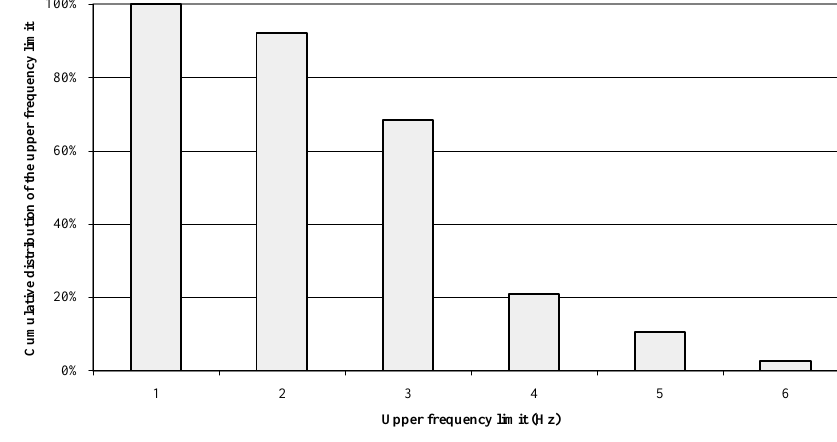
Figure 6 Fig. 6. Cumulative distribution of the NKE 25-2’s upper frequency limit.